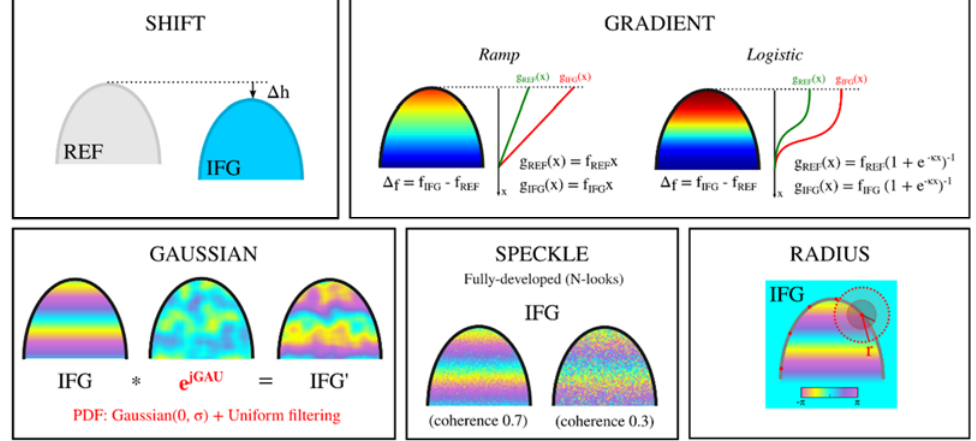
Figure 3. Sensitivity analysis with simulated data. Schematic depiction of the simulation experiments. SHIFT: robustness of the warp demodulation method against downward shifts Δ h of the IFG active lobe; GRADIENT: algorithm sensitivity to along-lobe deformation differences ∆ f between REF and IFG for ramp/logistic deformation gradients; GAUSSIAN: IFG affected by Gaussian noise; SPECKLE: IFG affected by fully developed speckle; RADIUS: Impact of patch radius r on performance.